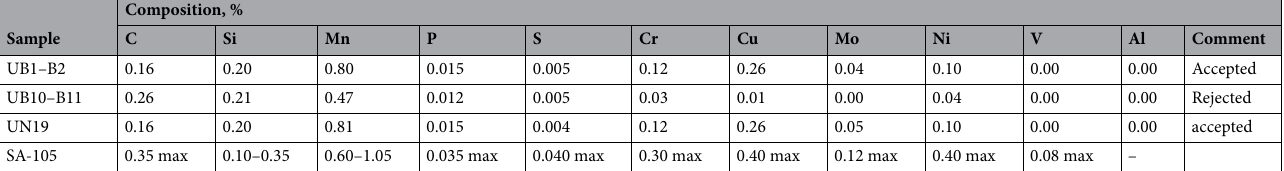
Table 4. Chemical composition of the investigated elbows. The sum of Cu, Ni, Cr, Mo, V shall not exceed 1.00%. The sum of Cr and Mo shall not exceed 0.32%.